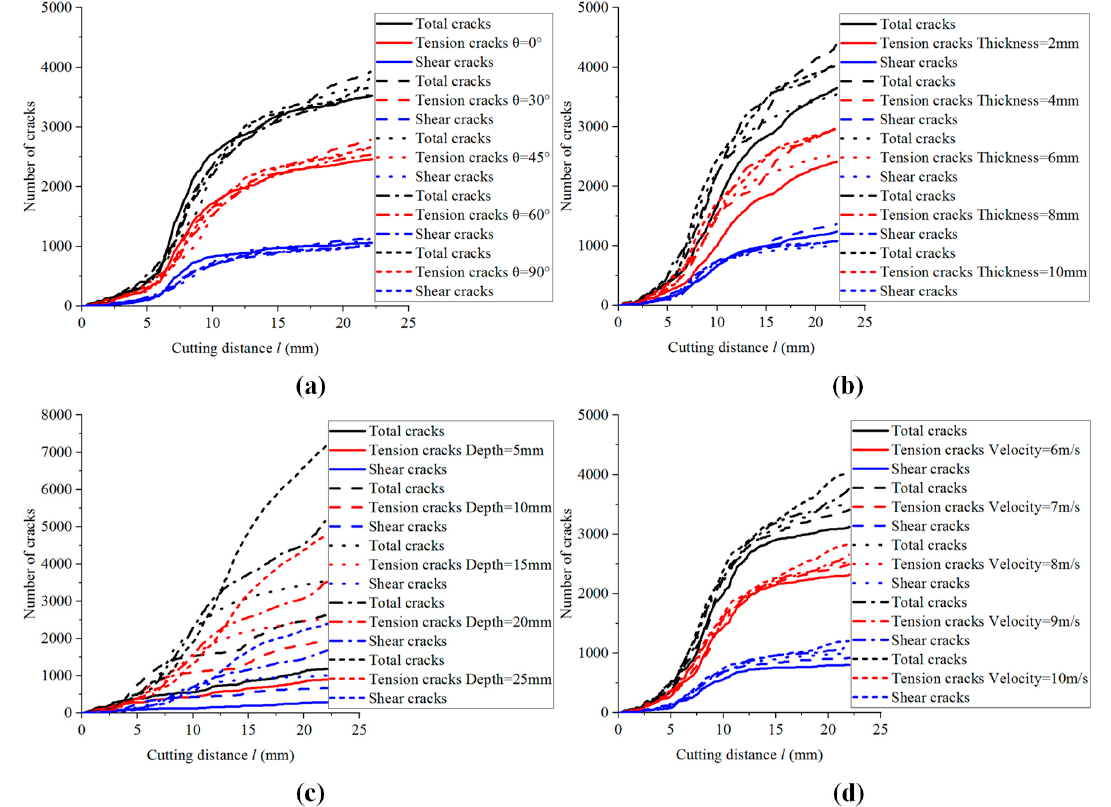
Figure 22. Variation characteristics of crack number of specimens with different influence factors.